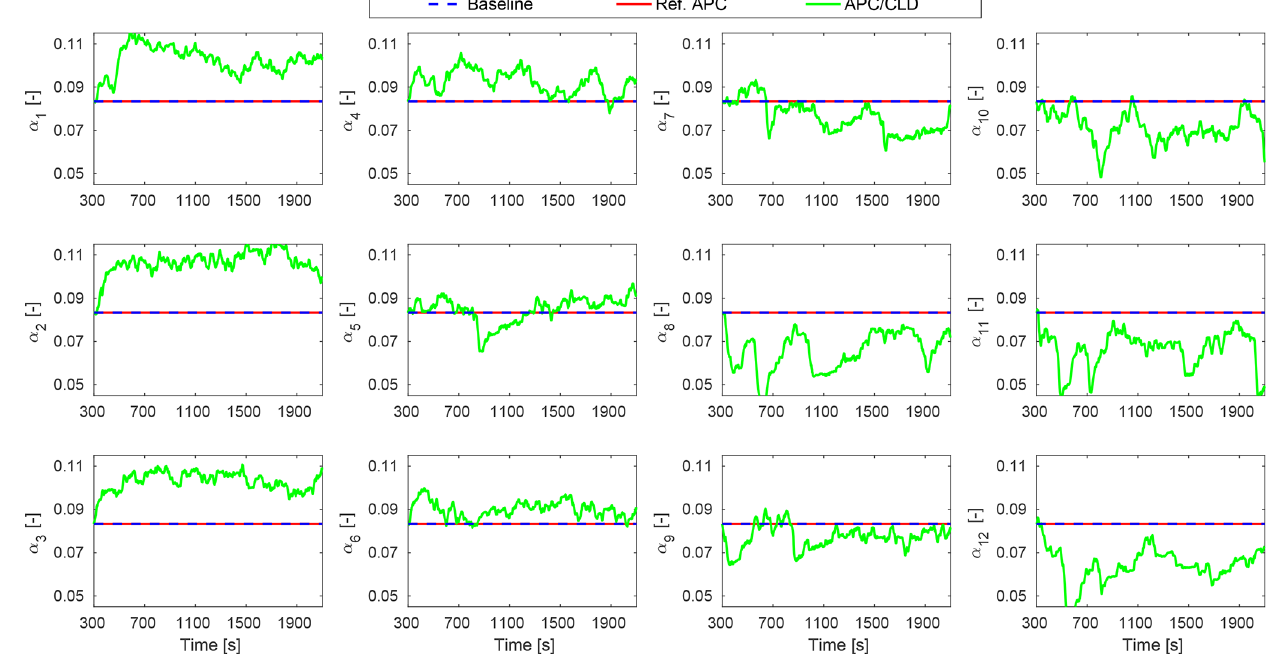
Figure 13. The trajectories of the power set-points with APC with coordinated load distribution (CLD). The baseline and Ref. APC rely on equal power set-points, i.e., α i = 1 /